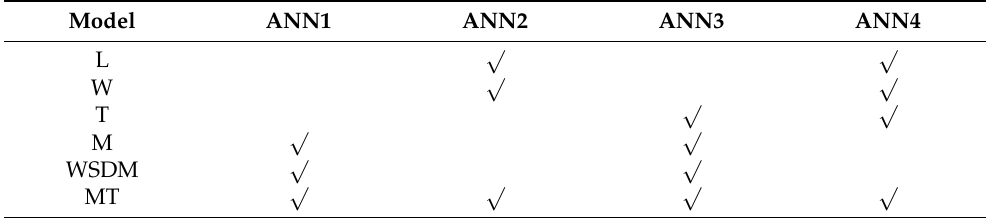
Table 1. Inputs are used in ANN models. ANN1 ANN2 ANN3